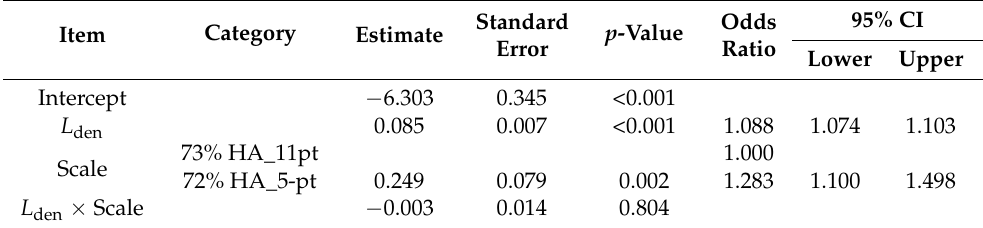
Figure 3. Comparison of exposure–response relationships for environmental noises measured by the 5-point verbal scale and the 11-point numerical scale: ( a ) Conventional railway noise, ( b ) Shinkansen railway noise, ( c ) Aircraft noise, and ( d ) Road traffic noise. Table 6. Multiple logistic regression analysis of Shinkansen railway noise surveys from 2003 to 2017 in Japan (AUC =